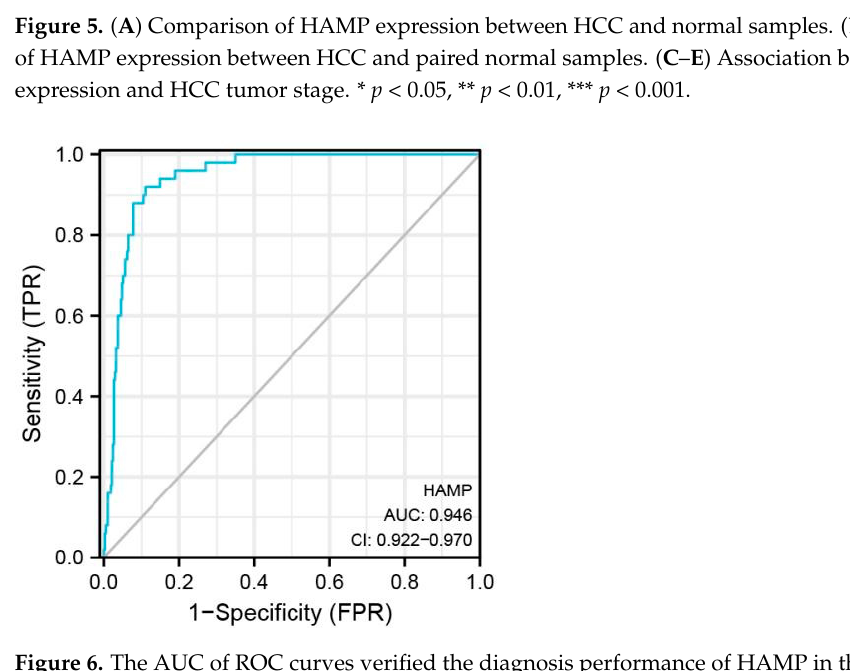
Figure 6. The AUC of ROC curves verified the diagnosis performance of HAMP in the TCGA.